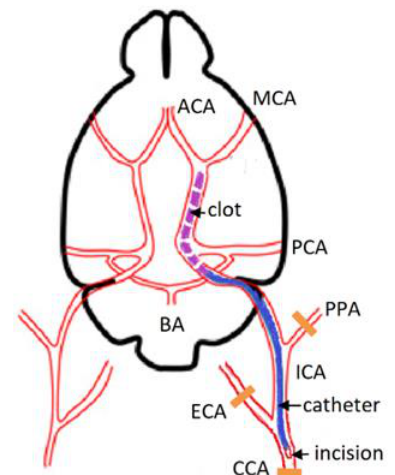
Figure 1. Scheme of thromboembolic occlusion of the MCA. CCA—common carotid artery, MCA— middle cerebral artery, ICA—internal carotid artery, PPA—pterygopalatine artery, BA—basilar artery, ECA—external carotid artery, ACA—anterior cerebral artery, PCA—posterior cerebral